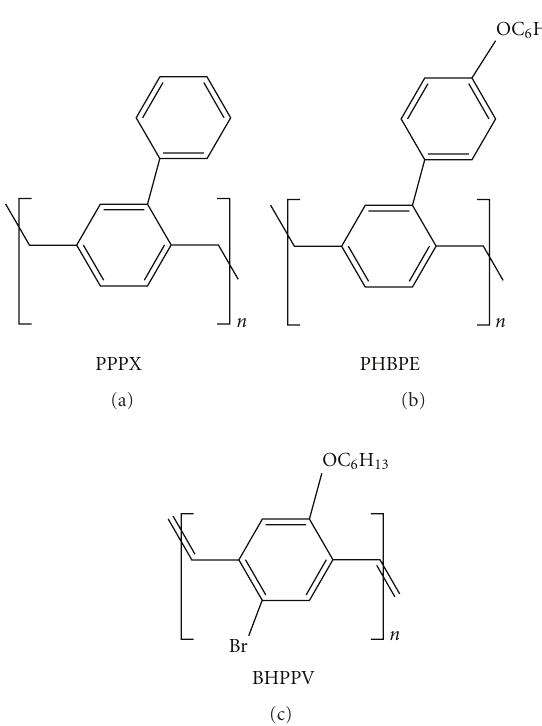
Figure 1: Chemical structures of the conductive polymers used for assembling the sensors.